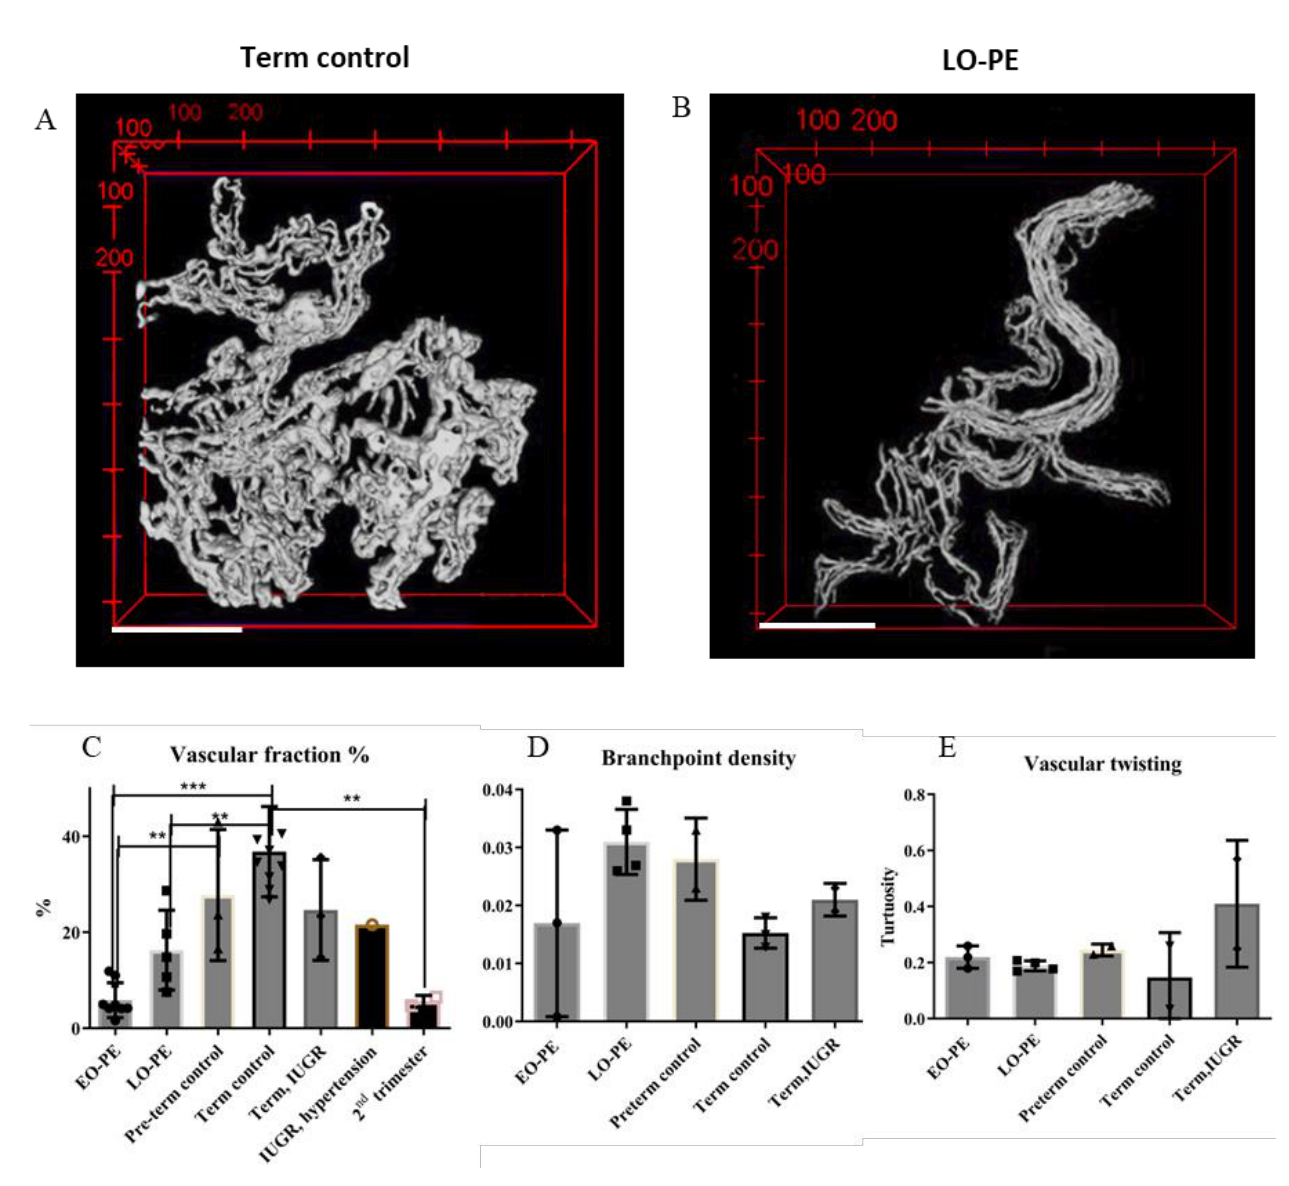
Figure 4. Placental 3D vasculature and network quantification parameters. Segmentation of a connected vascular network from ( A ) term control, ( B ) LO-PE terminal and intermediate villi. ( C ) The vascular fraction was calculated as vessel volume divided by corresponding villous volume of each image. EO-PE n = 1 placenta (images: 8), LO-PE: n = 1 (images: 5), preterm: n = 1 (images: 3), term control: n = 3 (images: 9), IUGR: n = 1 (images:3). ( D ) Branchpoint density (#branchpoints/network length (µm) ) . ( E ) Tortuosity of vessel segments. Tortuosity is defined as the ratio between the length of the curved vessel segment and the line distance in between two branchpoints. Samples in ( D ) and ( E ); EO-PE n = 1 placenta (images:3), LO-PE: n = 1 (images: 4), preterm: n = 1 (images: 2), term control: n = 2 (images: 3), IUGR: n = 1 (images: 2). ** p < 0.01, *** p < 0.001. Results are presented as means ± standard deviation. Scale bars: 200 μm.